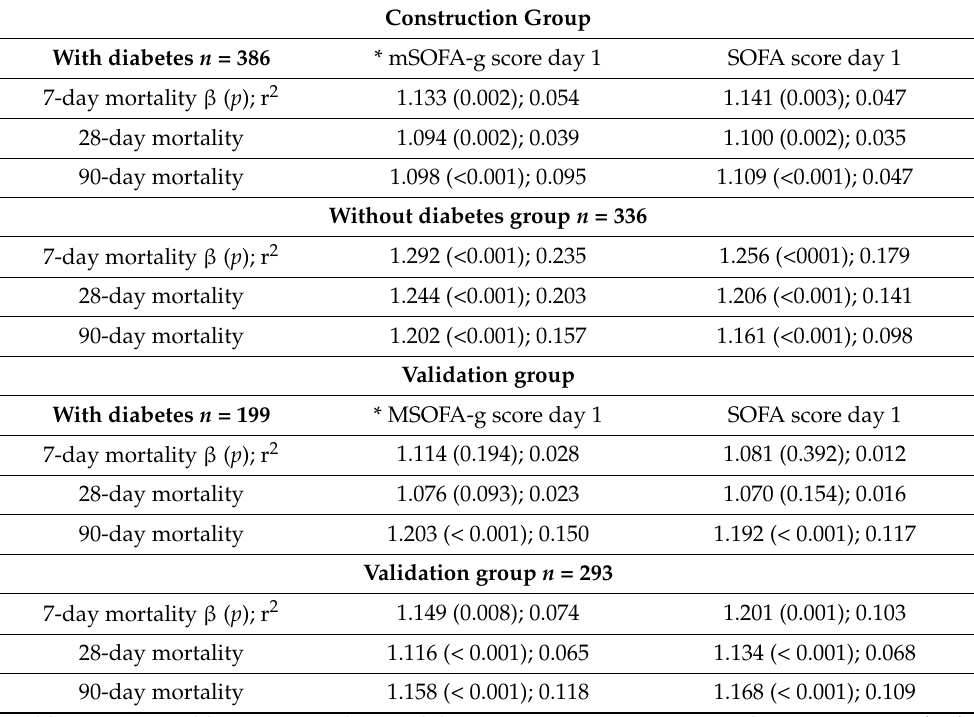
Table 5. The mSOFA-g score and SOFA score prediction power of mortality of participants with and without